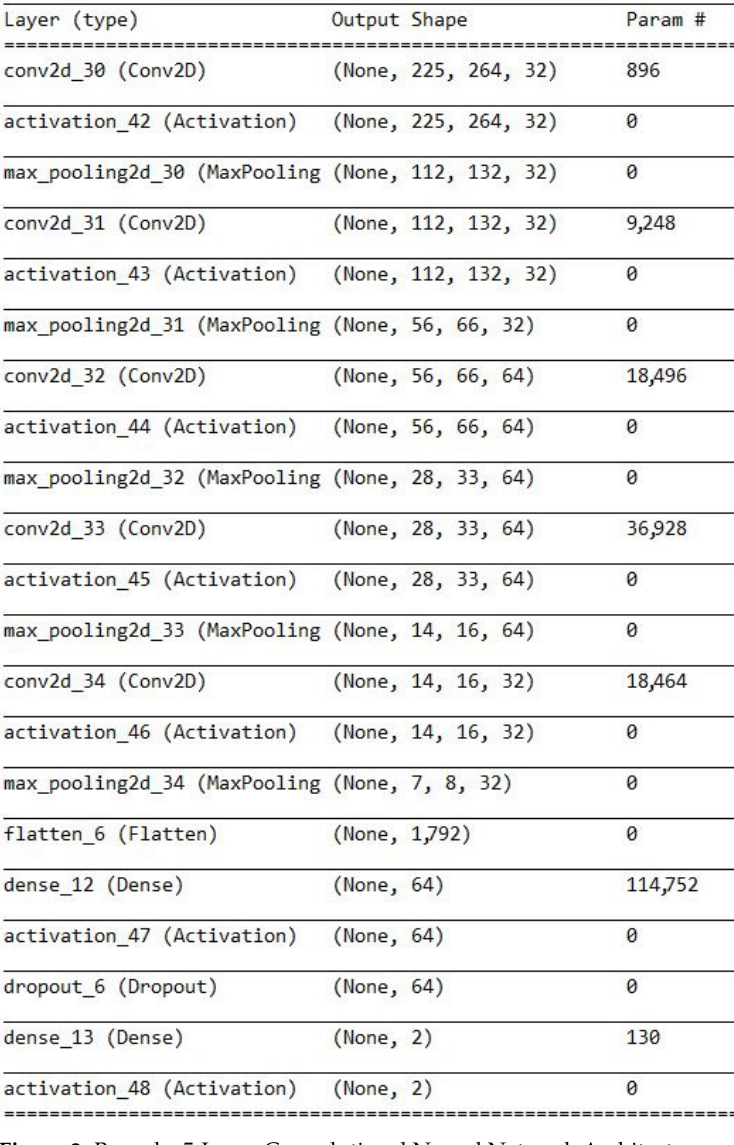
Figure 2. Bespoke 5-Layer Convolutional Neural Network Architecture. We also trained a random guess classifier which forms the baseline against which the performance of our bespoke CNN models was compared. This was deemed necessary due to the absence of ‘reliable’ and ‘reproducible’ existing work to perform a direct comparison. All experiments were conducted in 50 epochs to obtain the best parameter sets. Performance evaluation was based on accuracy and cross-entropy loss observed during model training, validation, and